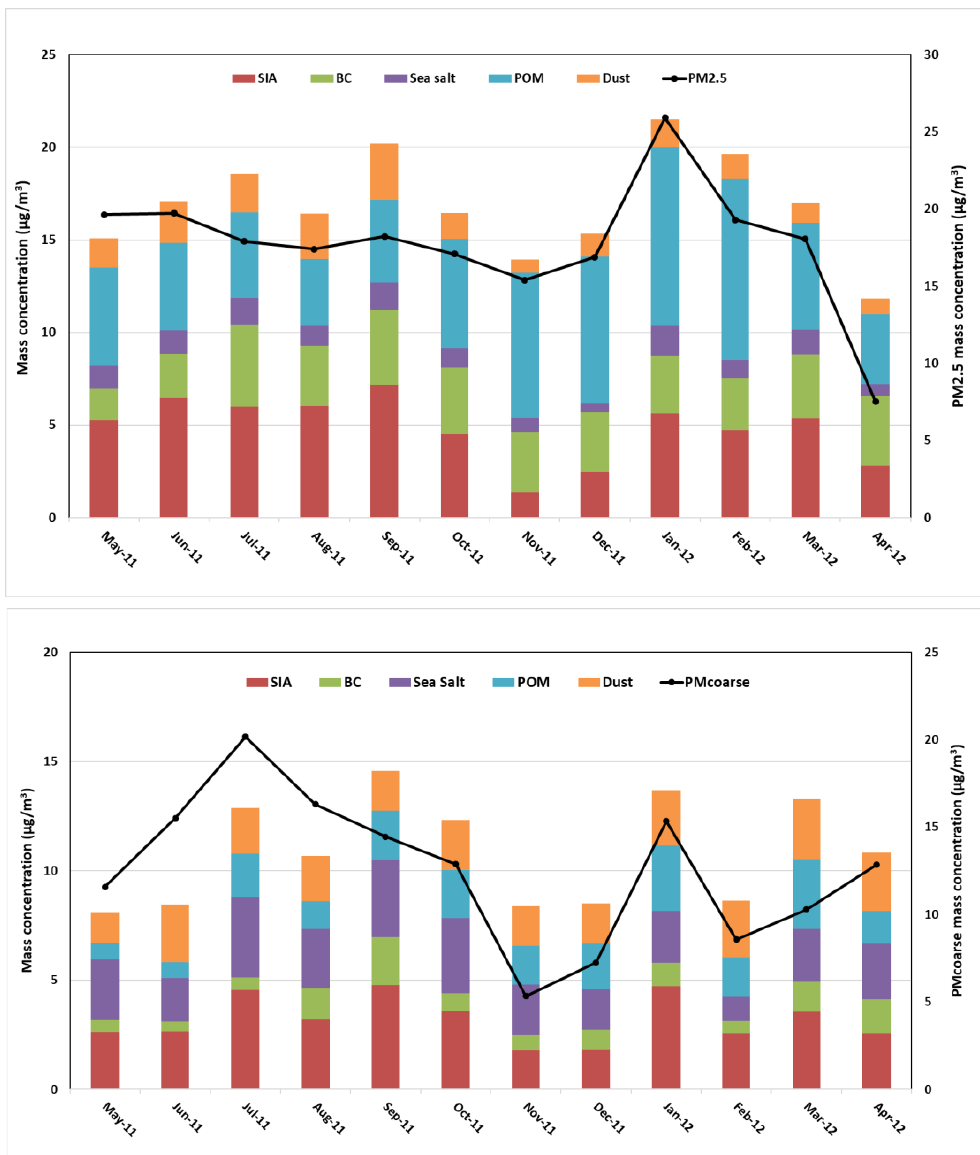
Figure 3. Monthly mass closure for PM 2.5 ( upper panel) and PM coarse ( bottom panel) samples collected at Tetouan.